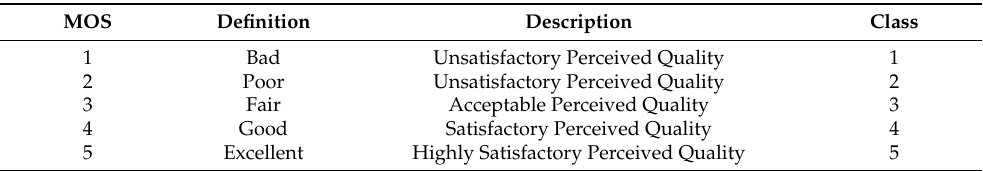
Table 3. Mean opinion score